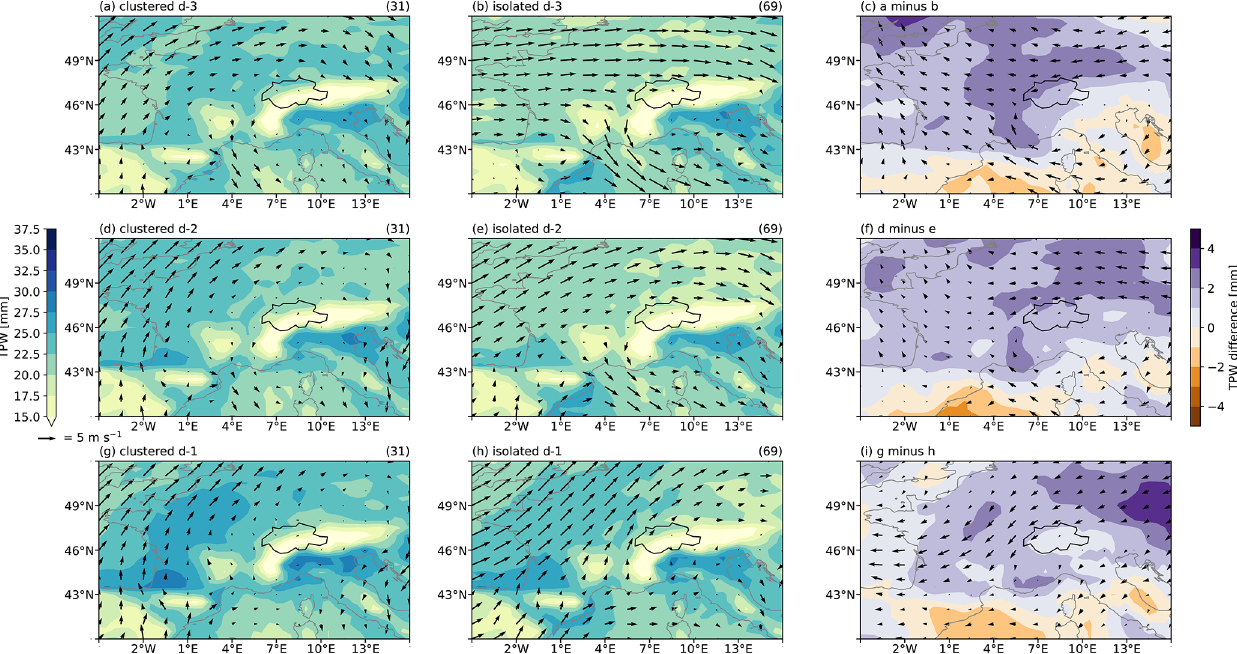
Figure 8. TPW (colored contours) and wind at 850hPa (vectors) for the 3d prior to clustered (a, d, g) and (b, e, h) isolated hail days north of the Alps. The differences are shown in panels (c) , (f) , and (i) . See caption of Fig. 5 for details.